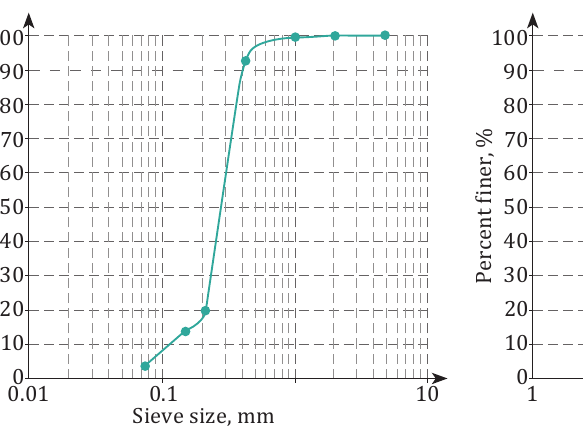
Figure 3. Particle size distribution curve for soil